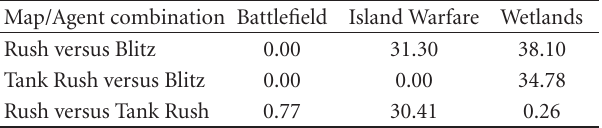
Table 2: Average standard deviation in game length (seconds) for agent combinations on specific maps.